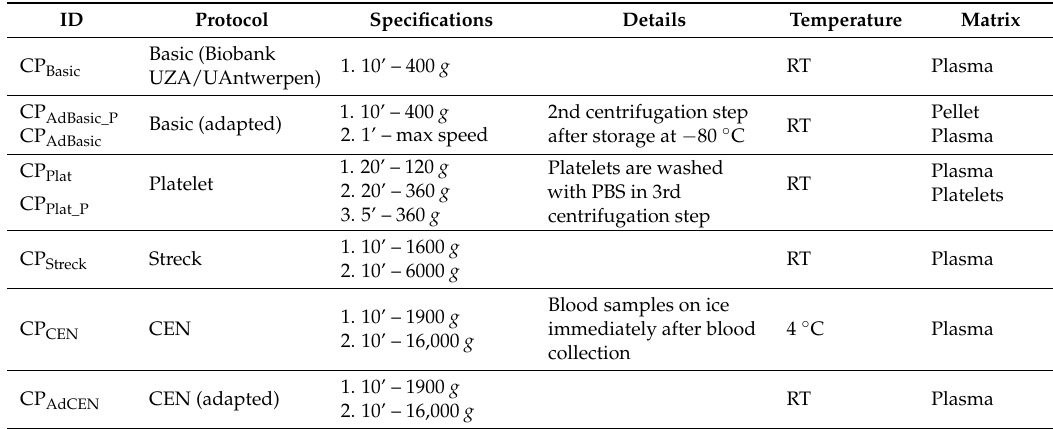
Table 1. Centrifugation protocols for cfDNA/cfRNA